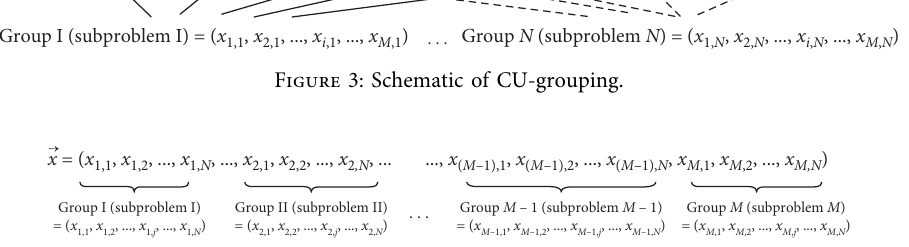
Figure 4: Schematic of